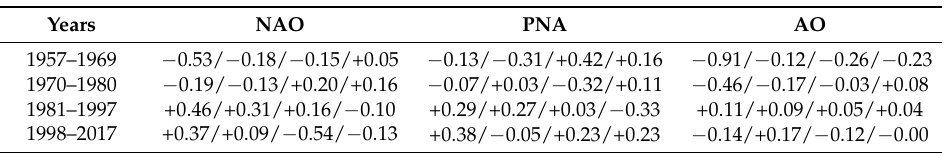
Table 5. The prominent teleconnection indexes for the 1957–2017 epochs [4] in Table 2. The indexes are the North Atlantic Oscillation (NAO), Pacific North American (PNA), and the Arctic Oscillation (AO). The indexes are shown for all seasons